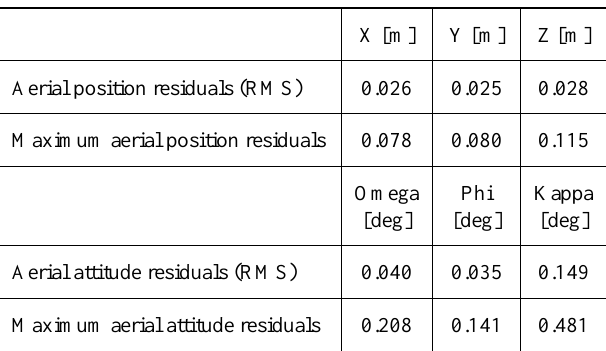
Table 4. Estimated accuracy of the GNSS/INS data